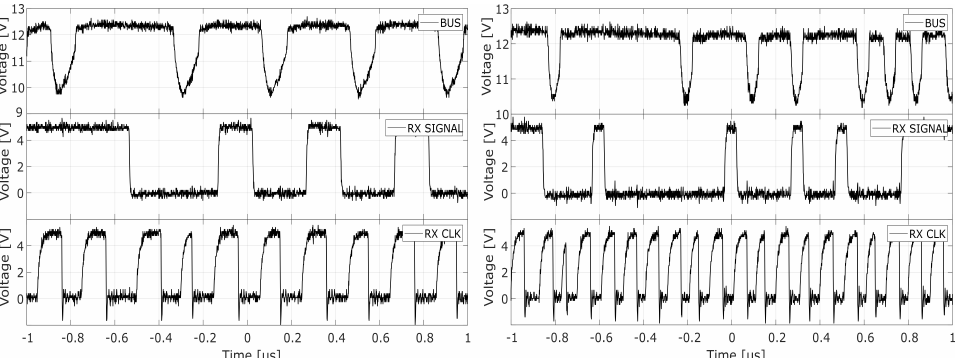
Figure 12. Transmission Bus, received data and received clock at 2 Mbps (switching capacitors = 820 pF) for the 3-Switches ( left ) and the H-Bridge ( right ) transmitters.